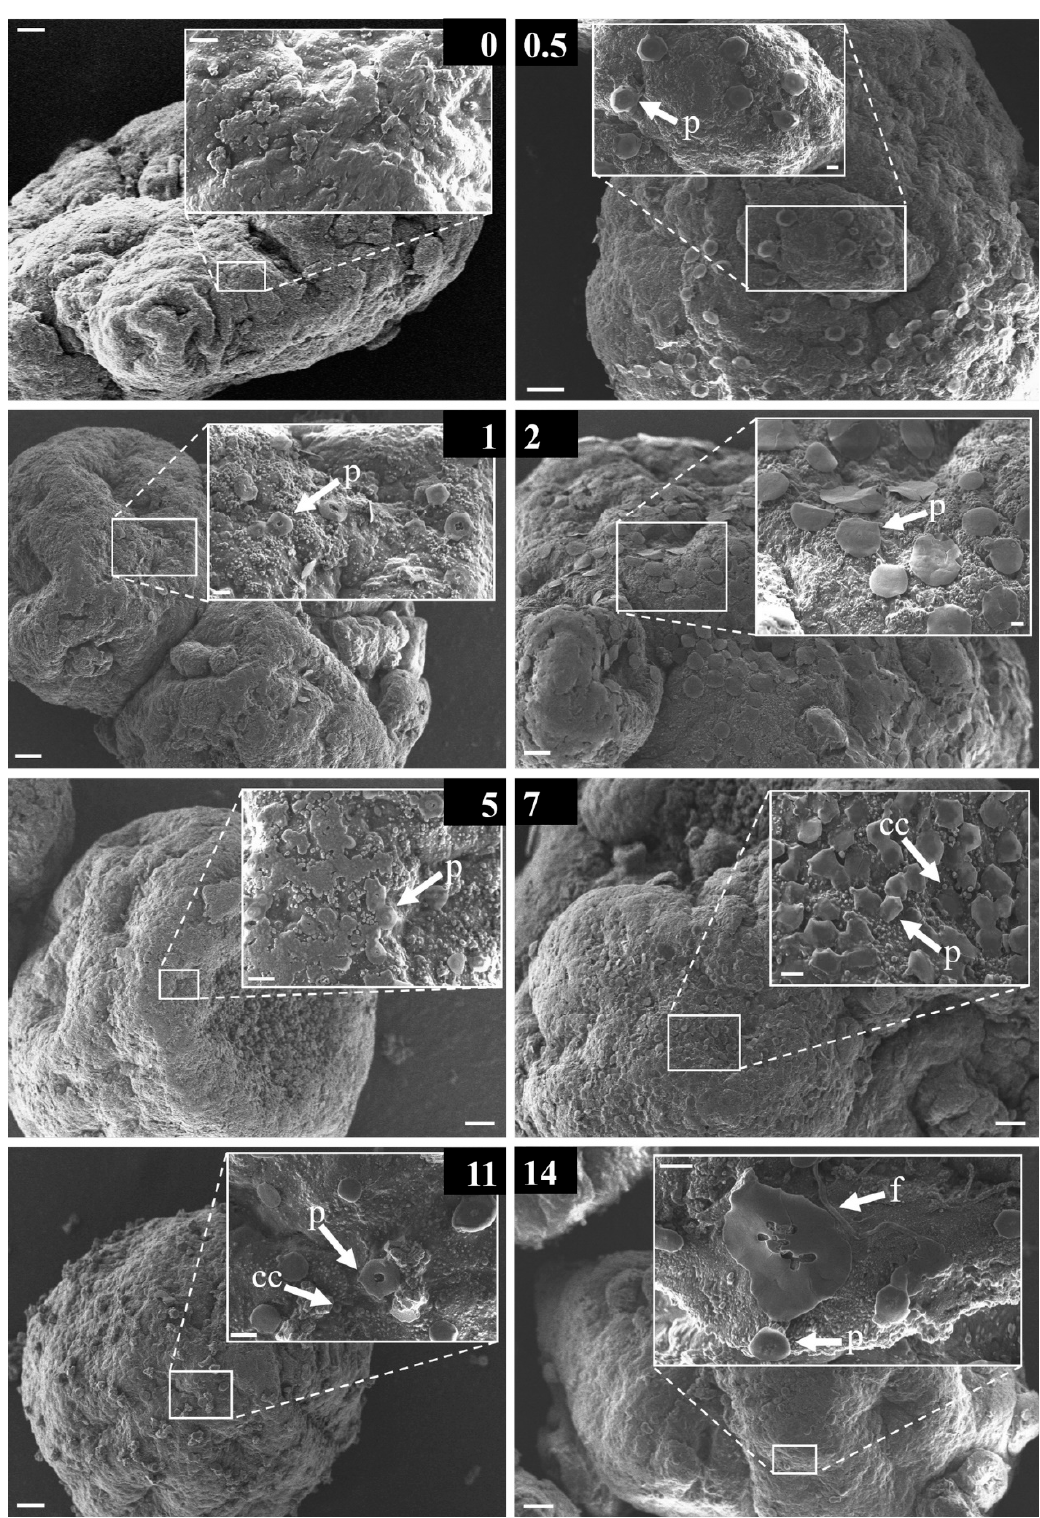
Figure 8. Scanning electron microscopy images of PVC incubated in freshwater. Numbers in black boxes indicate incubation times in days (0 = raw material, 0.5 = half day, 1 = one day, 2 = two days, 5 = five days, 7 = seven days, 11 = eleven days, 14 = 14 days of incubation). Microorganismal structures are highlighted with arrows. cc = coccoid bacteria, f = filamentous structure, p = platelet structure. Scale bar: Large image 10 µm, magnified image 2 µm.